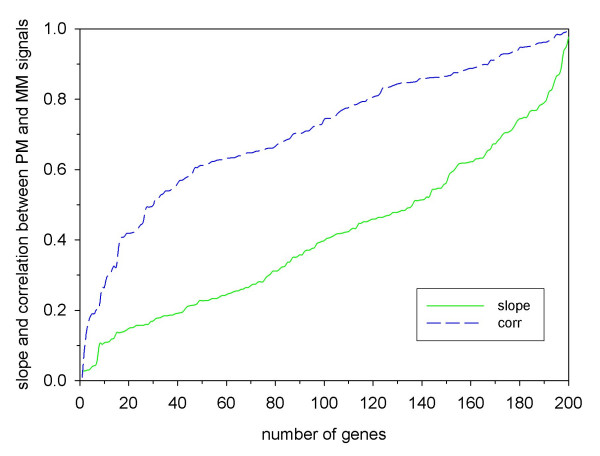
Relation between PM and MM signals. Slope and Pearson correlation coefficient calculated between the PM and MM signals from 200 random chosen probe sets. Only probe sets are used which represents one gene. Both slope and correlation are sorted from low to high. See figure 6 for further explanation and individual examples.